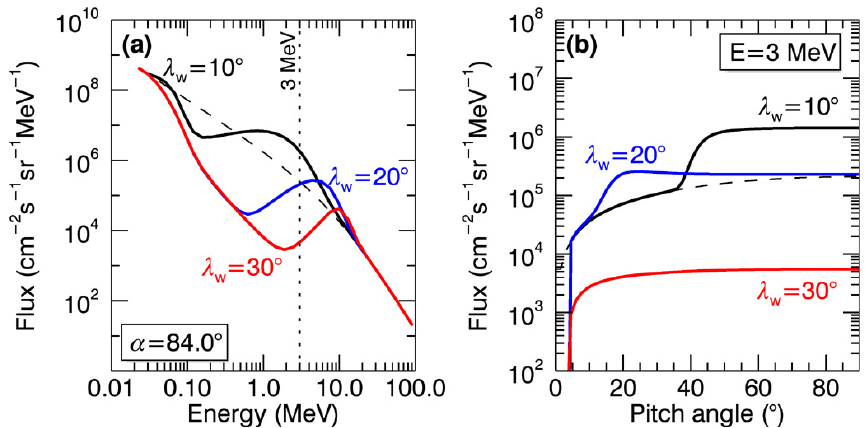
Fig. 4. Electron fluxes after 30 days for constant wave intensity extending to ± λ w . Dashed line shows initial condition.